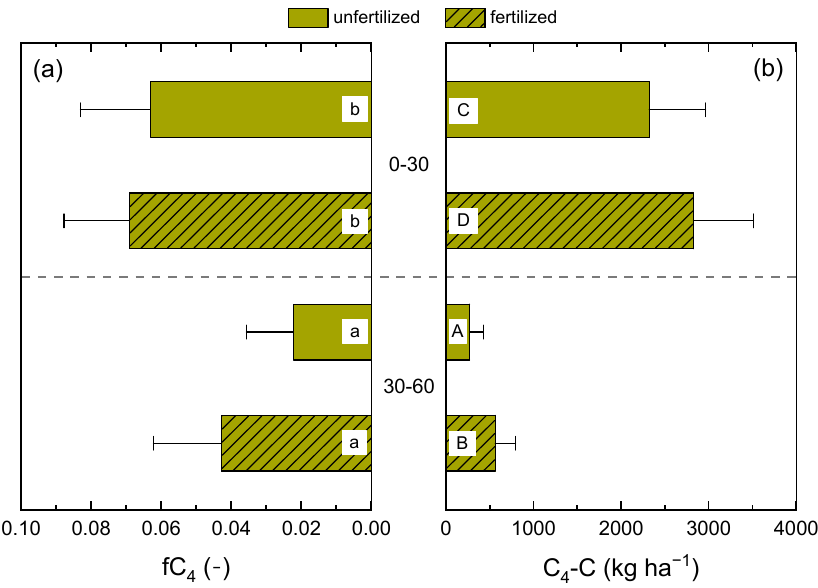
Figure 2. Fractions ( a ) and amounts ( b ) of maize (C 4 ) carbon in the soil organic carbon (SOC) stock of the 0–30 and 30–60 cm soil layers of CR6 (50 % maize) compared to CR10 (no maize) after 16 years. Fertilized treatments received biogas digestate. Soil sampling was conducted in spring 2020. Error bars represent standard deviations. Different lowercase and capital letters indicate significant differences between the fractions and amounts of C 4 carbon, respectively. Table 1. Analysis of variance (ANOVA) and comparisons of means for content and isotope delta values of soil organic carbon (SOC) in soil samples taken from two different crop rotations, soil depths and fertilizer treatments after 16 years of differences in crop rotation and fertilization. Effects or differences were considered as non-significant (n.s.) for p ≥ 0.05, and level of significance is indicated as follows: 0.05 > p ≥ 0.01: *, p < 0.001: